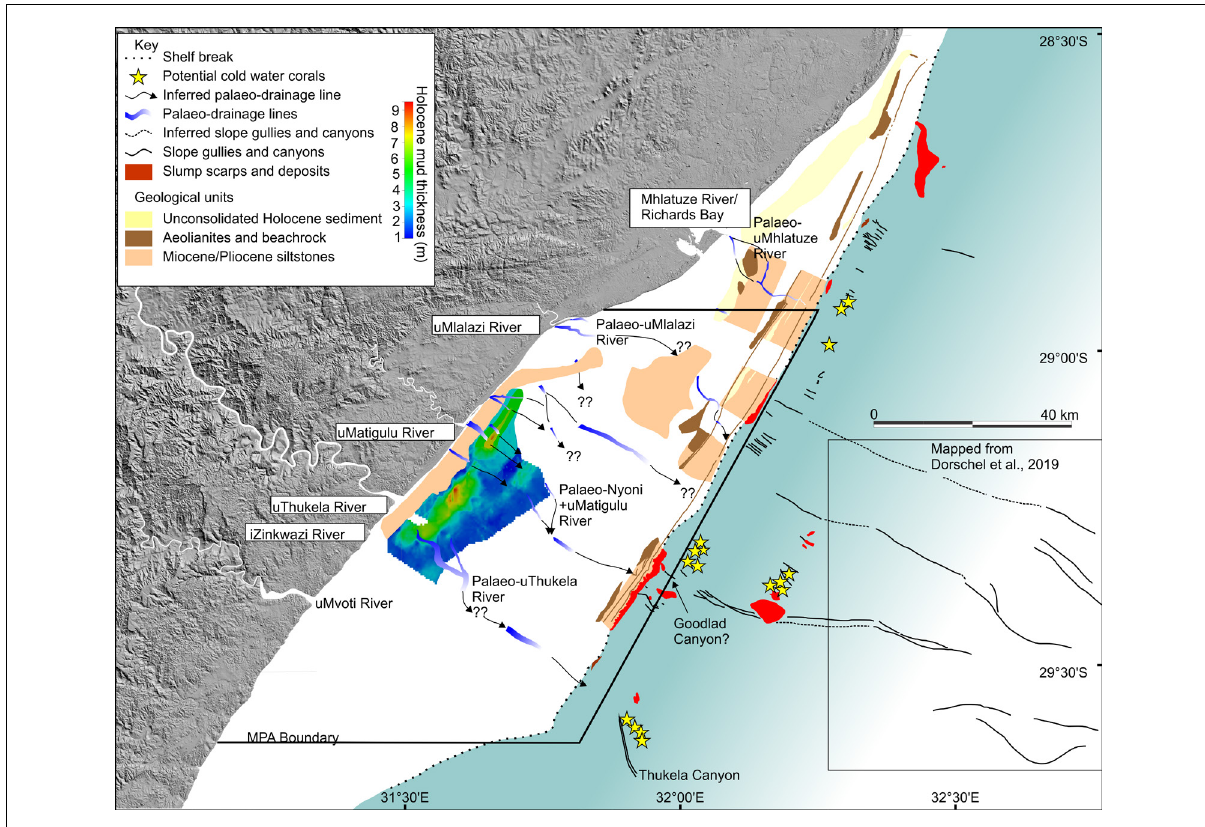
Figure 3: New detailed seafloor geology and geomorphology of the uThukela Banks Marine Protected